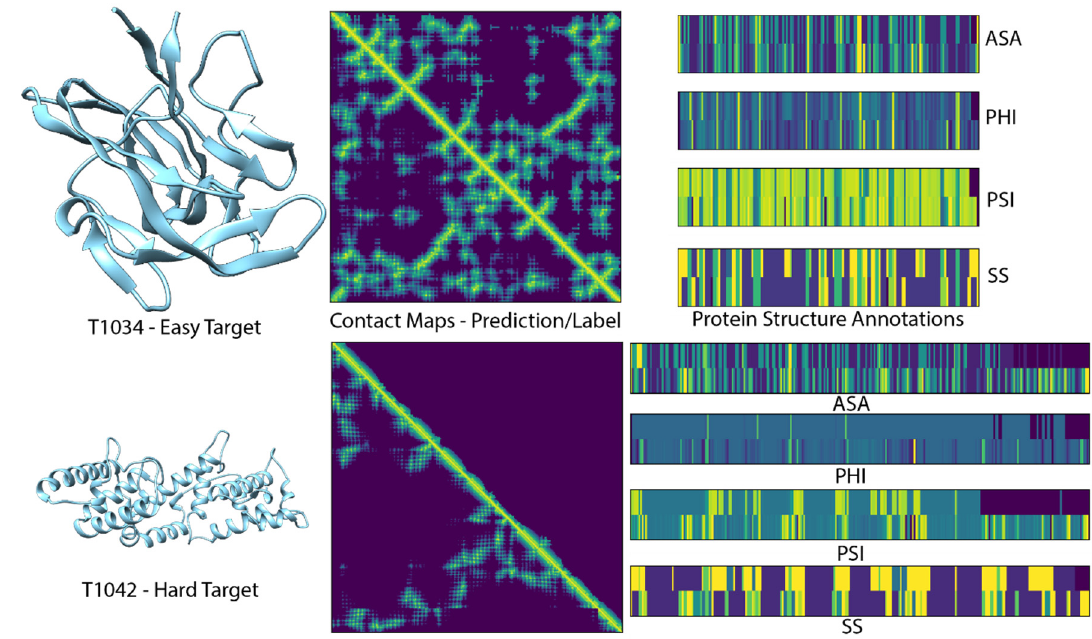
Figure 1. Two example targets from the CASP14 test set. Left: experimental structures from which labels were derived. Middle: contact maps predicted with ProSPr ensemble on top of the diagonal; label on bottom. Right: visualization of auxiliary loss predictions on top with labels at bottom. Accessible surface area (ASA), torsion angles (PHI, PSI), secondary structure (SS).